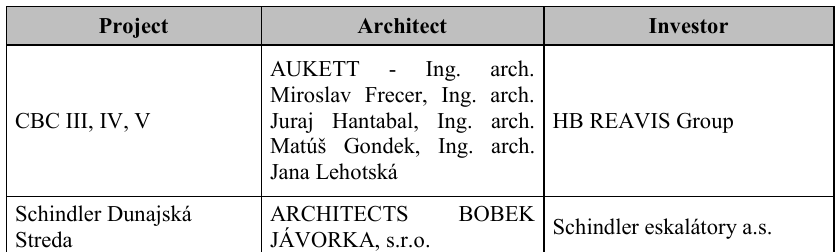
Table 4. The most significant green building projects, architects and investors in